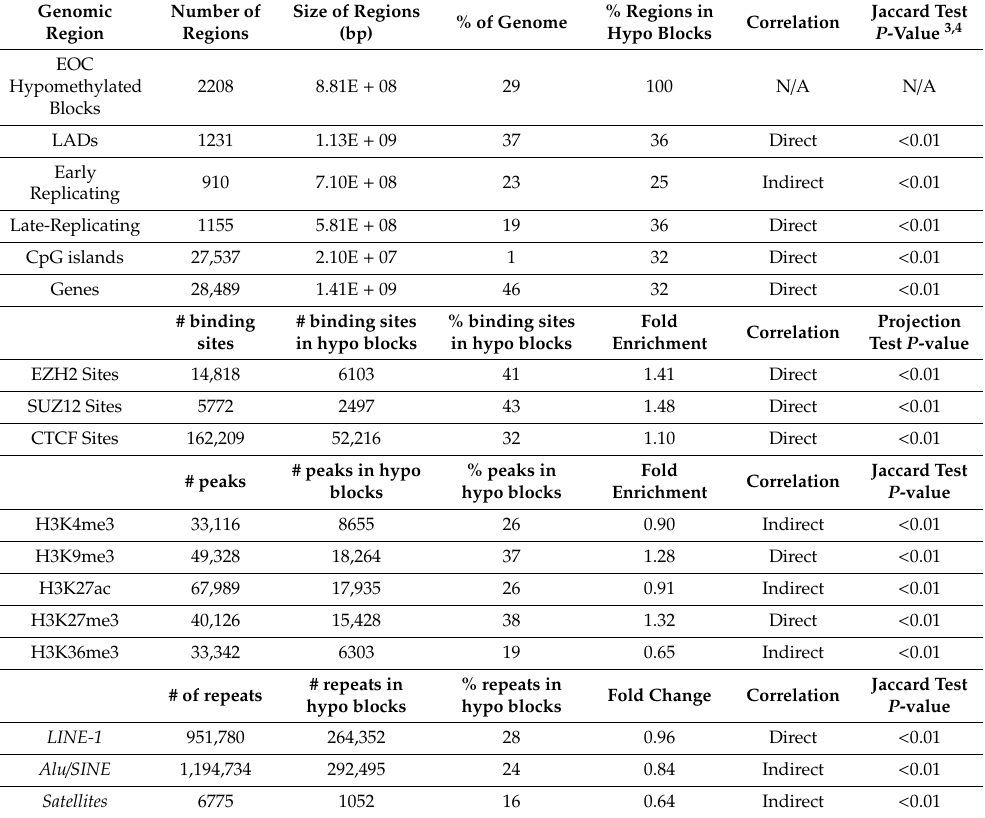
Table 1. Correlation of EOC hypomethylated blocks with genomic features 1,